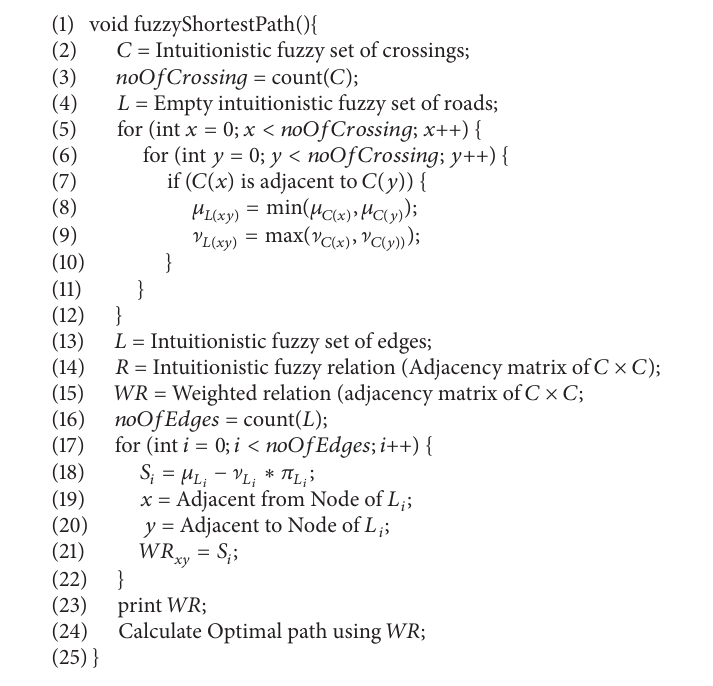
Algorithm 4: IF digraph in travel